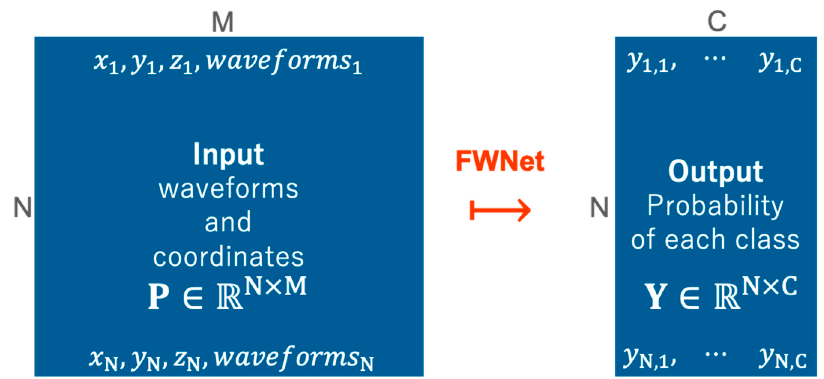
Figure 2. Problem statement in this study. Our model predicts the probability of each class ( (cid:1799) ∈ (cid:1337) (cid:2898)(cid:3400)(cid:2887) ) from the input data ( (cid:1790) ∈ (cid:1337) (cid:2898)(cid:3400)(cid:2897) ) consisting of waveforms and coordinates (the first peak return) associated with the